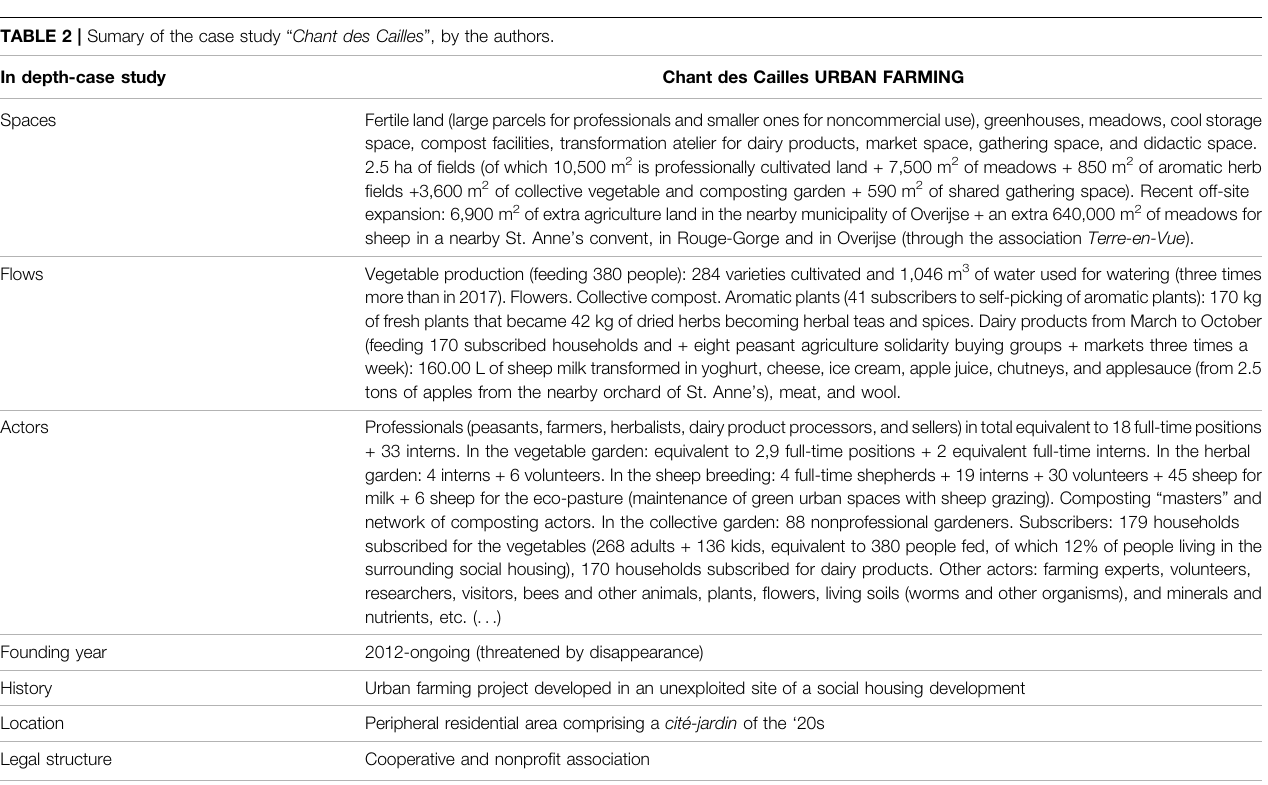
TABLE 2 | Sumary of the case study “ Chant des Cailles ” , by the